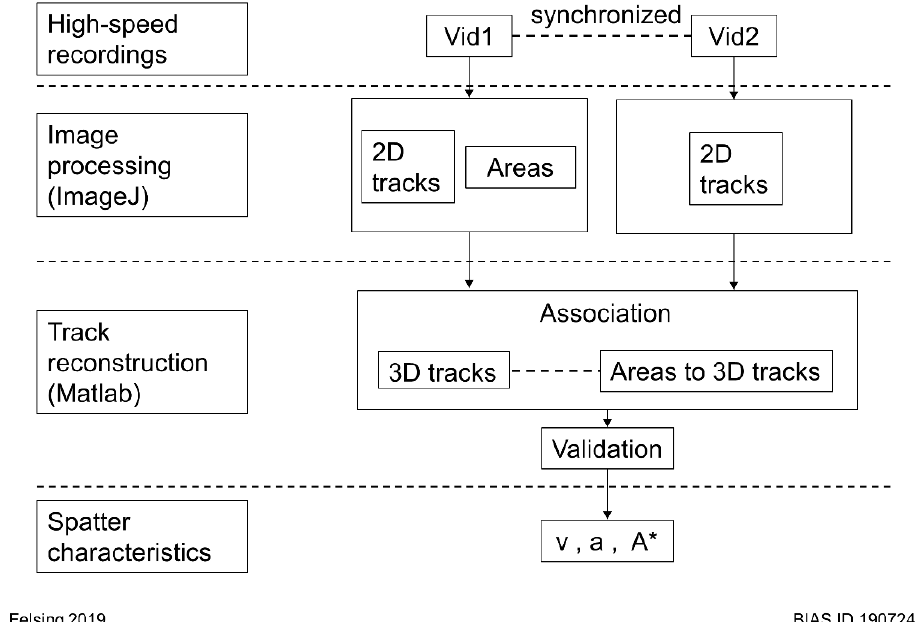
Figure 5. Scheme for the determination of spatter characteristics.